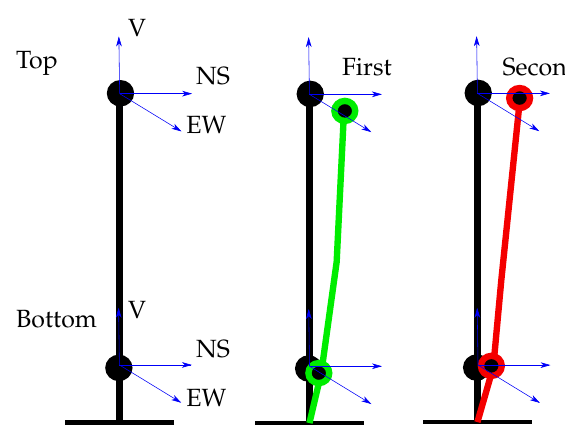
Figure 9. Measured degrees of freedom and schematic illustration of the first two